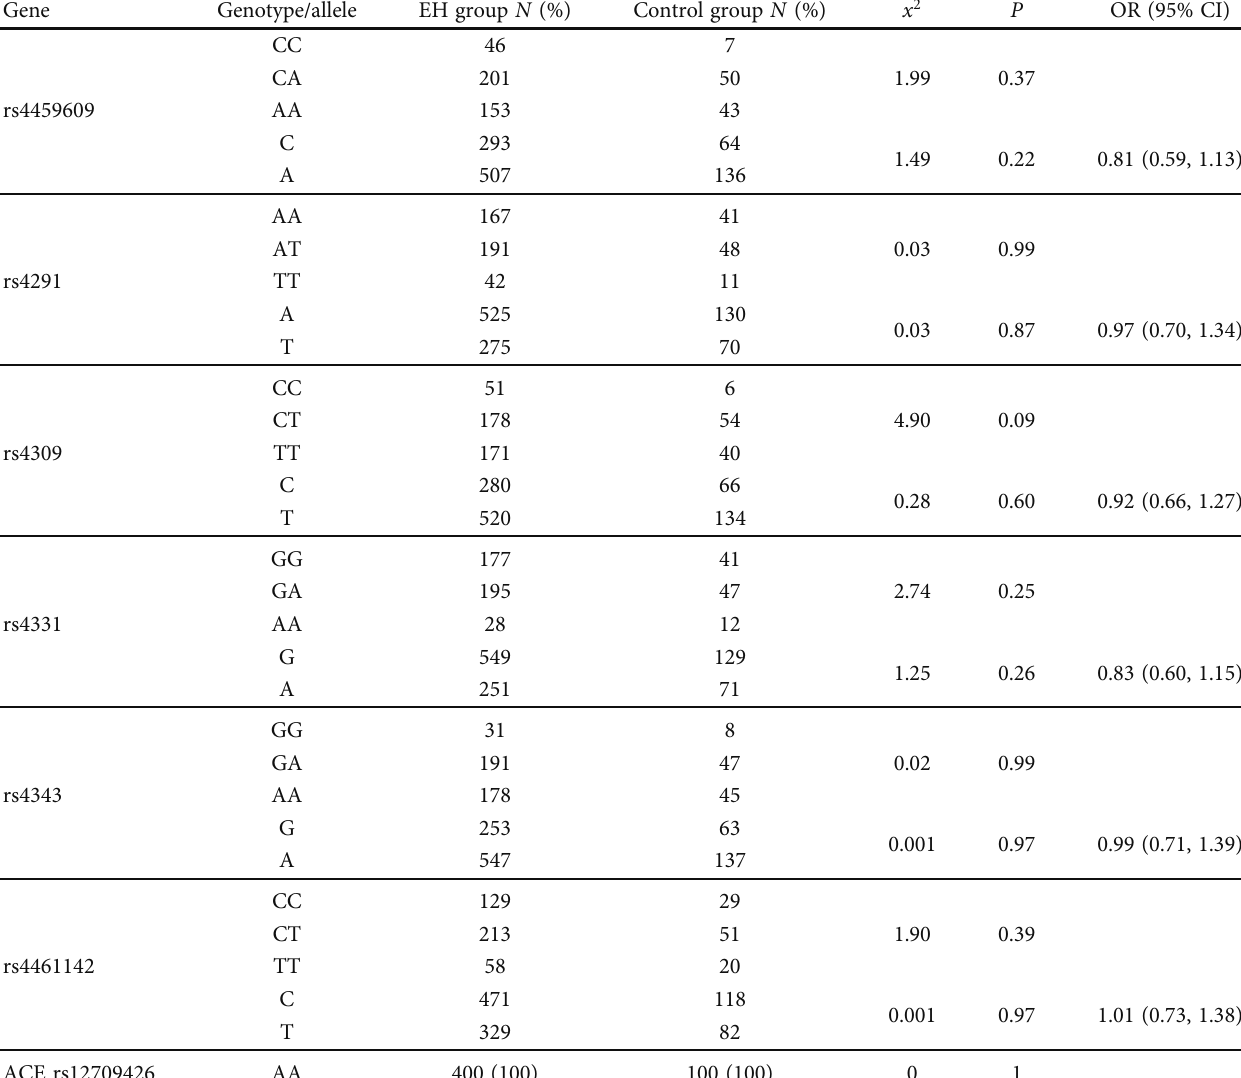
Table 4: Comparison of ACE genotypes between the EH and control